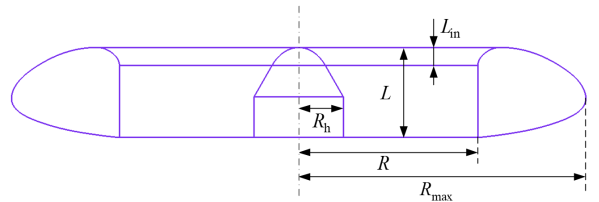
Figure 14. Schematic diagram of the duct profile of the 400 ducted fan.